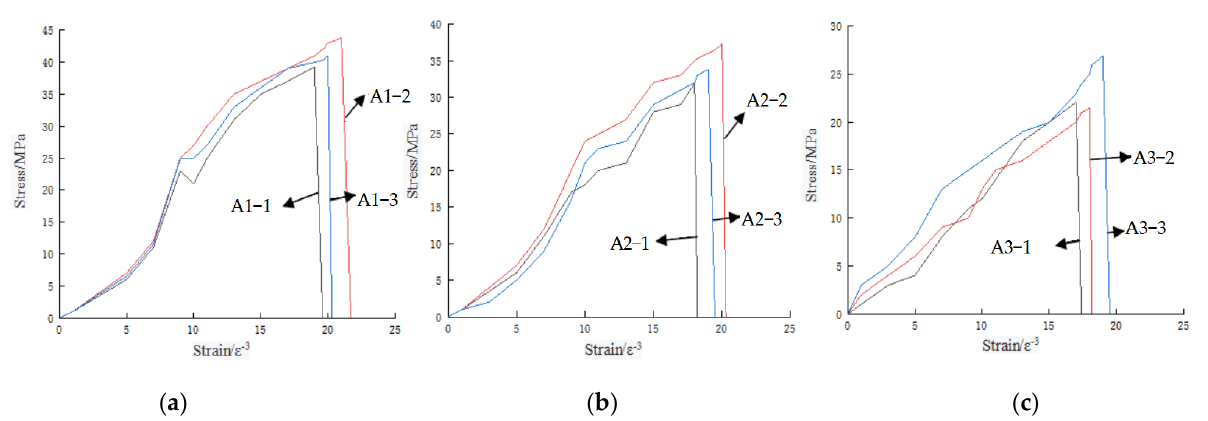
Figure 3. Full stress – strain curve of coal sample under different gas pressure. ( a ) The gas pressure is 0 MPa; ( b ) the gas pressure is 1 MPa; ( c ) the gas pressure is 2 MPa.